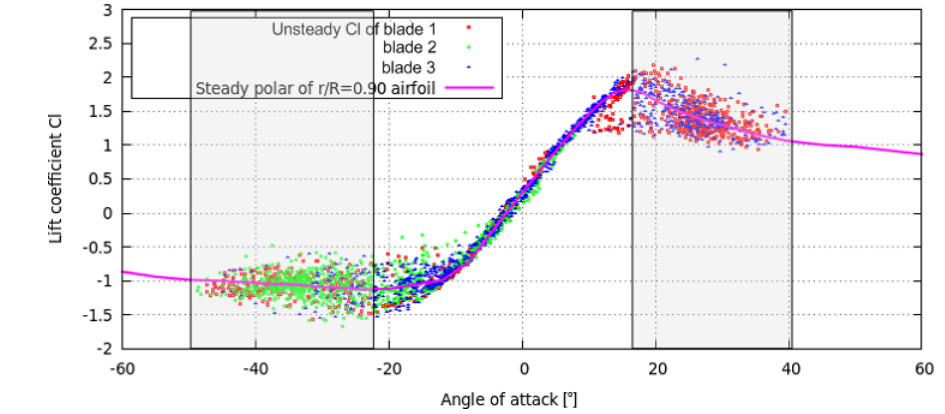
Figure 14. C L –AOA plot at r/R = 0 . 90 spanwise position. Wind speed 42.5ms − 1 ; TI 11%; yaw angle 30 ◦